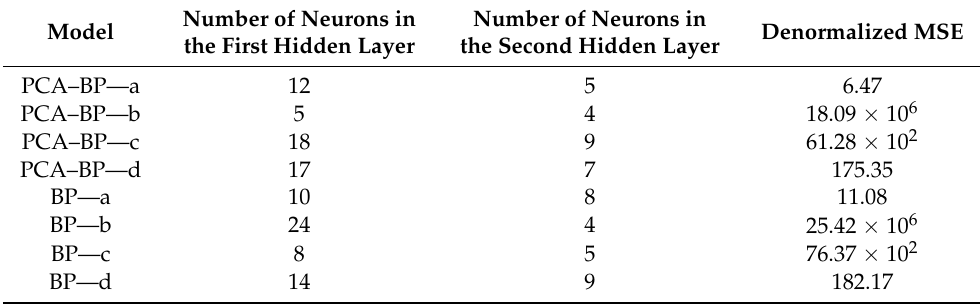
Table 4. Number of hidden neurons and mean square error for the neural network models.